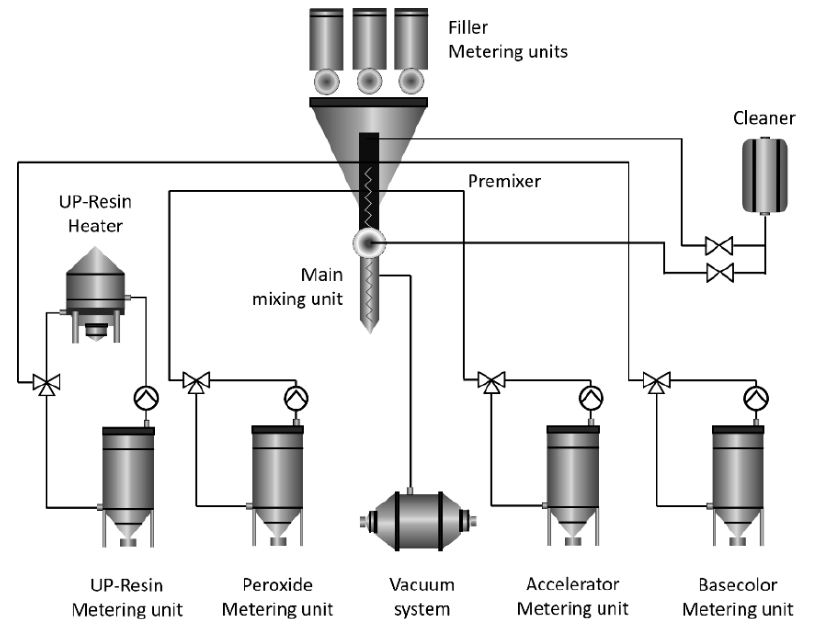
Figure 1. Manufacturing process flow of the polymer composite.